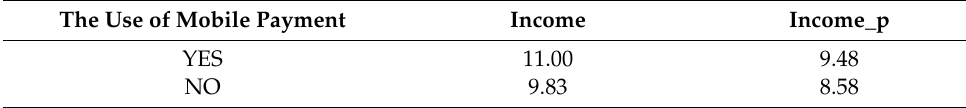
Table 3. Summary Statistics: Household